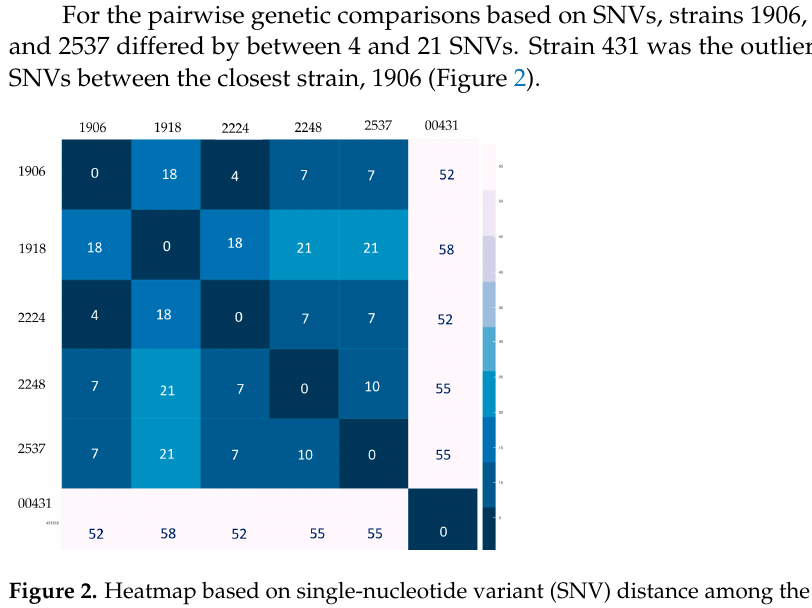
Figure 2. Heatmap based on single-nucleotide variant (SNV) distance among the six Mycobacterium tuberculosis Central-Asia (CAS) SIT 2545 genomes from Brazil. Darker blue is indicative of shorter genetic distance whereas light blue to white indicates a larger number of SNVs between isolates. Out of the 1691 genomes, 1350 (79.83%) passed the quality control (genomic coverage > 95%). The six novel strains, clustering together, were positioned on a subclade which shares a common ancestor with the second subclade with seven known L3 strains at the tips of the nodes. These genomes are from the United Kingdom ( n = 4; ERR072023; SRR2100697; SRR2101190; and SRR2100980), and an unknown origin but possibly from Azerbaijan, Bangladesh, Belarus, Pakistan, Philippines, South Africa, and Ukraine (= 3; SRR6964598; SRR6797470; and SRR6964614). This distinct L3 clade comprising of two subclades were positioned the closest to four other L3 clades (Figure